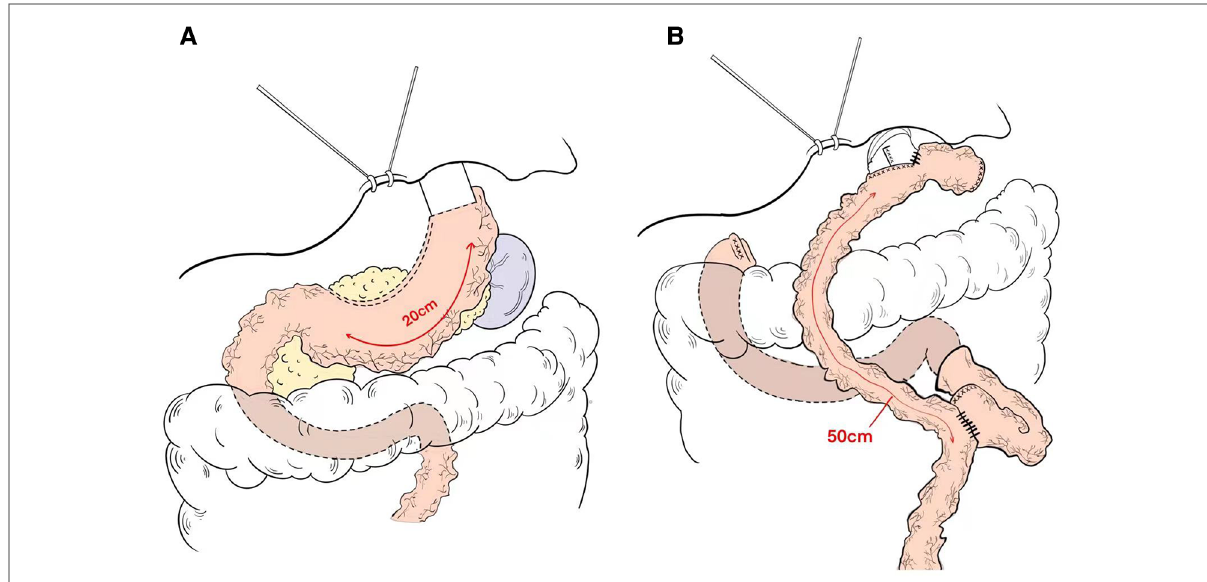
FIGURE 2 Schema of reconstruction after ( A ) proximal gastrectomy with tube gastric and ( B ) total gastrectomy with roux-en-Y esophagojejunostomy